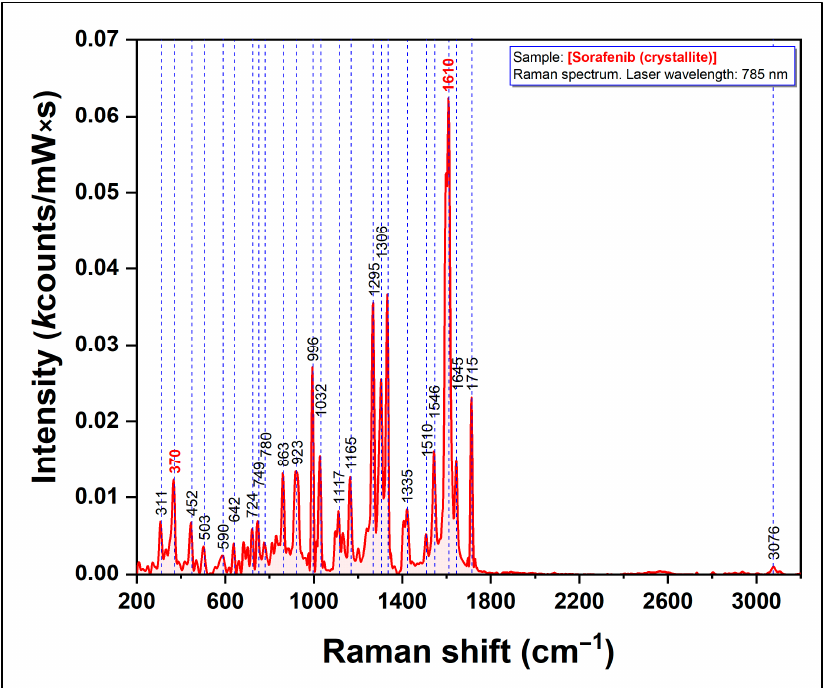
Figure 1. Raman spectrum of pure sorafenib molecules (the excitation laser is 785 nm).